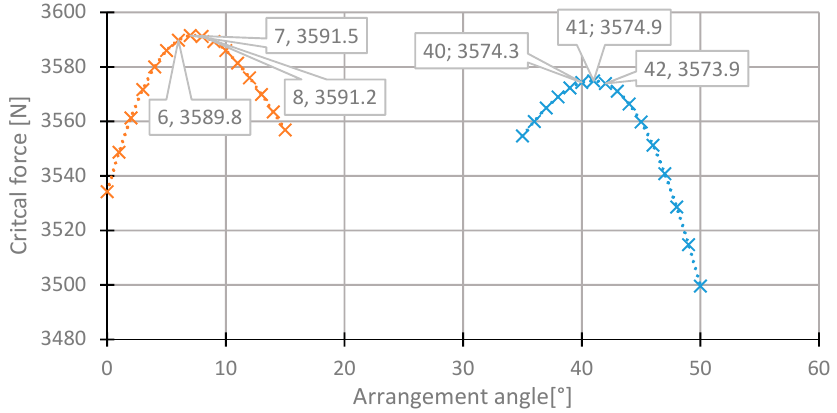
Figure 13. The critical force depending on the angle in the fourth laminate layer of the [45/ − 45/ − 45/45] arrangement for the change of the arrangement angle in the range from 0° to 90°.